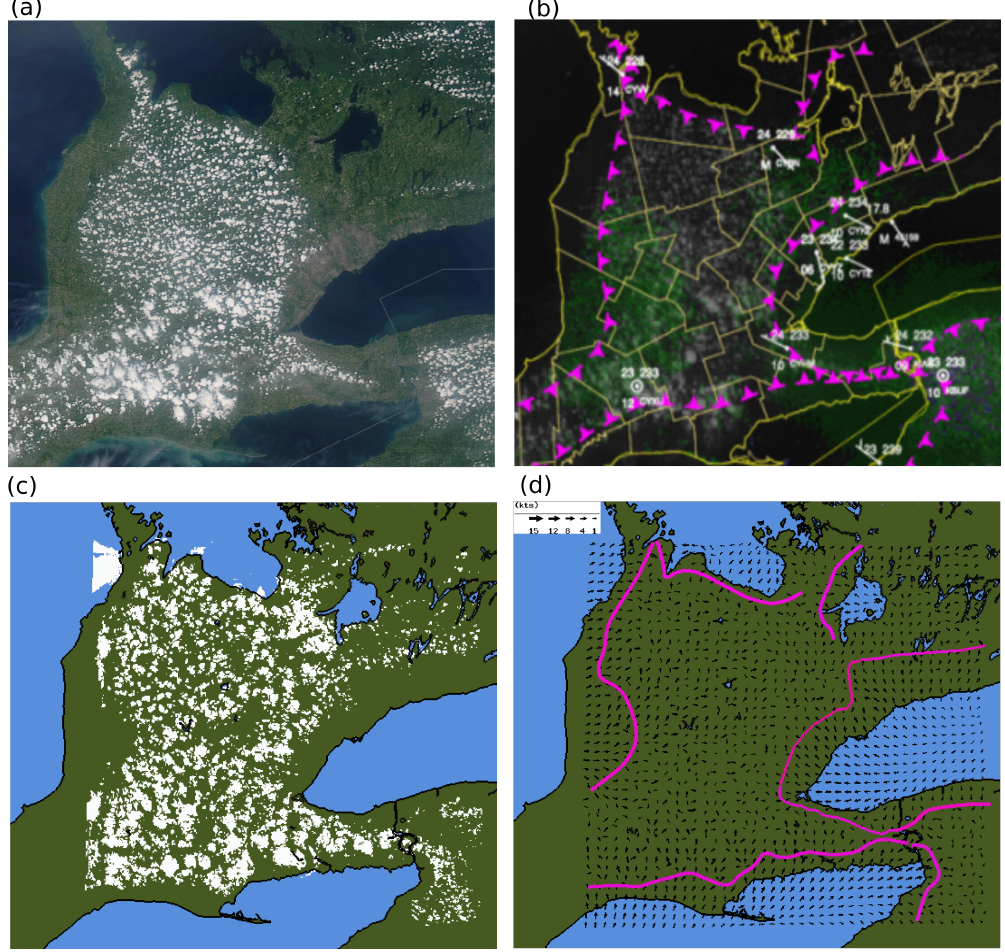
Figure 10. Cloud cover structure and lake breeze fronts on 18 July 2014 at about 1500 EDT (1900 UTC). ( a ) visible clouds as seen by MODIS Aqua satellite with about 250-m grid spacing at 1450 EDT (adapted from http://ge.ssec.wisc.edu/, last access 12 December 2019). ( b ) Lake-breeze front (ma- genta triangles) analysis at 1500 EDT provided by iCAST using GOES-East satellite imagery, radar, and in-situ measurements. ( c ) Prediction in TOR-GEM250 of the cloud covering at least 20% of the grid cell (white), and ( d ) of the manually identified lake breeze front locations, with near-surface wind vectors (few vectors shown for sake of clarity) at 1450